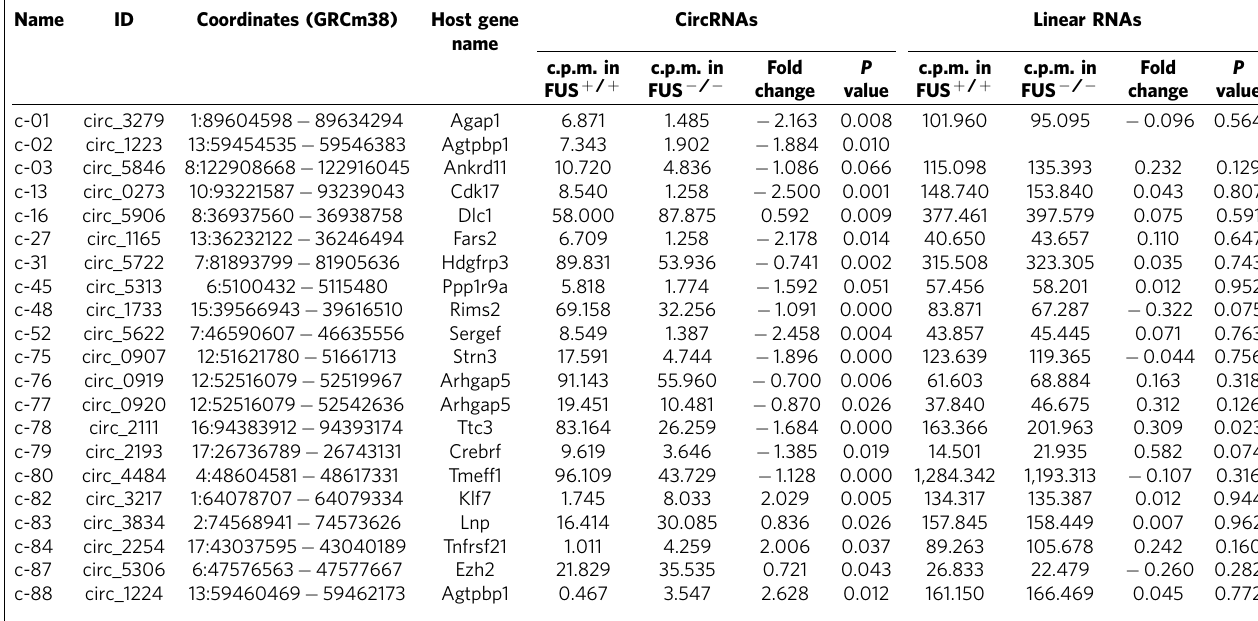
Table 2 | List of circRNAs analysed and their linear